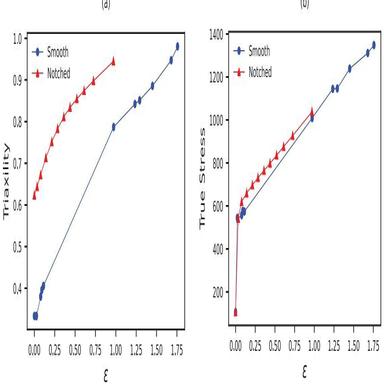
Tracking of voids in both (a) notched and (b) smooth iron sample.